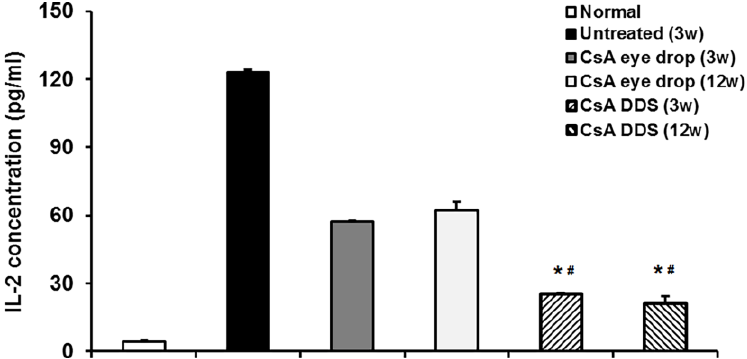
Figure 6. Interleukin-2 (IL-2) level in the aqueous humor of rabbit eyes after keratoplasty. The ELISA test demonstrated that IL-2 concentration significantly increased in the untreated group at three humor as compared to eye drops at all time points. * p < 0.01 vs. untreated, # p < 0.01 vs. CsA eye drops ( n = 6 per group). Reproduced from Reference [194]